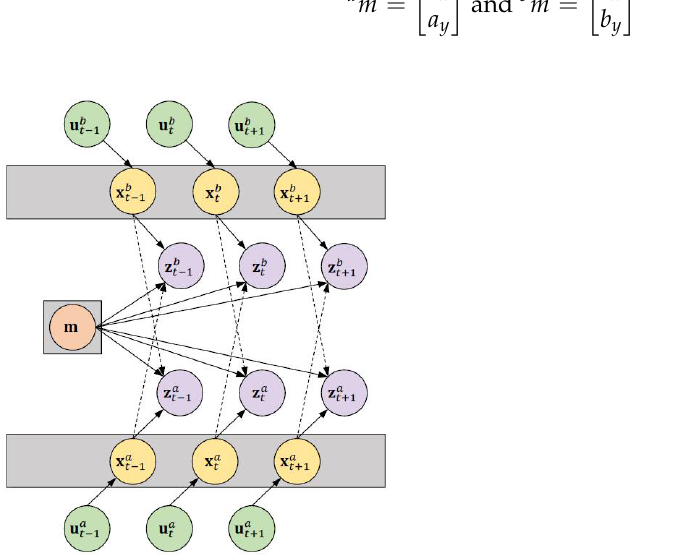
Figure 3. Graphical model of the collaborative SLAM problem for two robots a and b . T transforming m